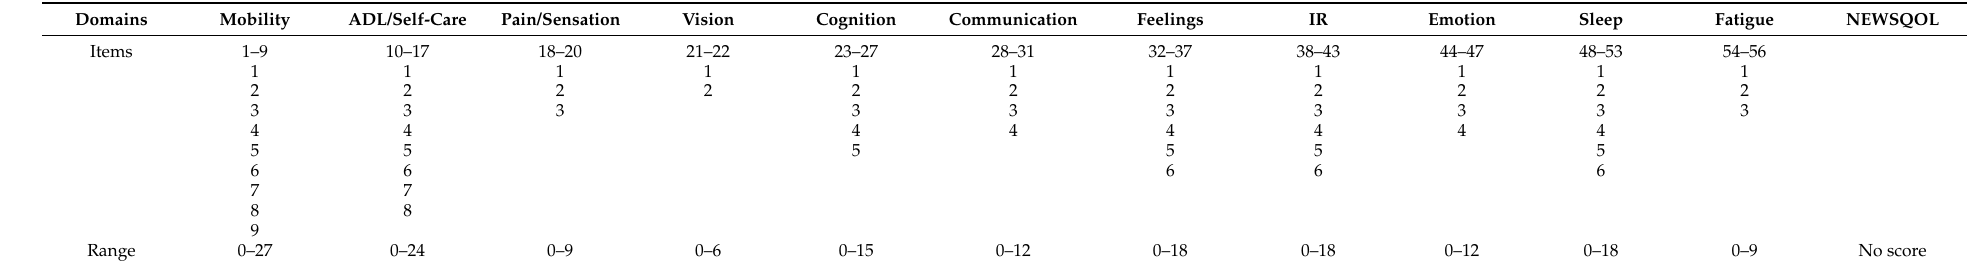
Table 1. Scoring